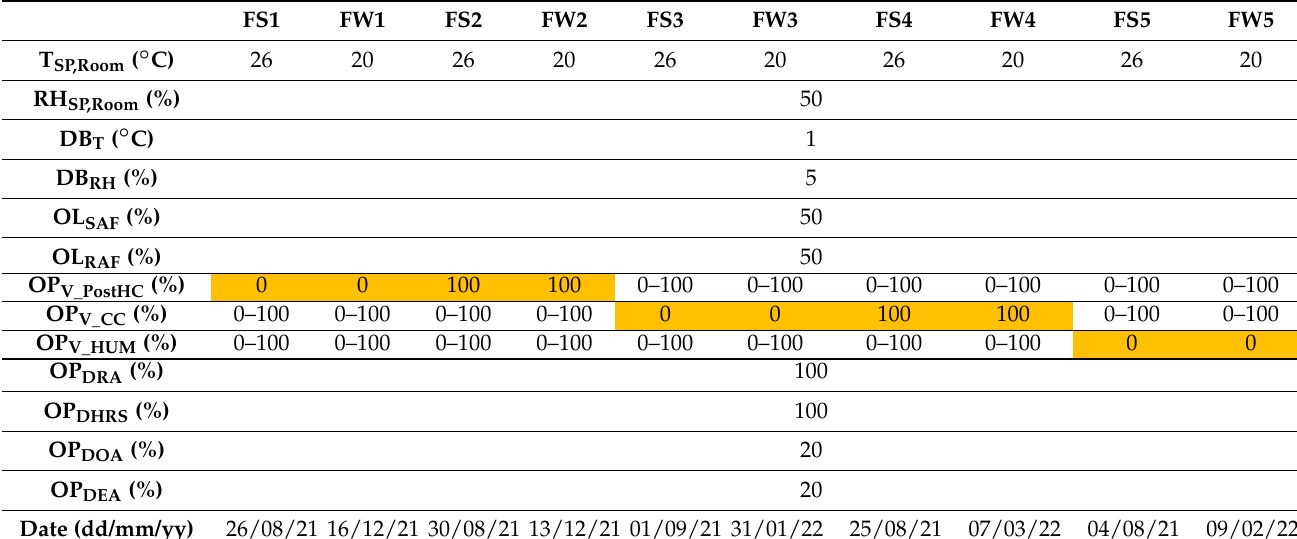
Table 6. Boundary conditions of the faulty